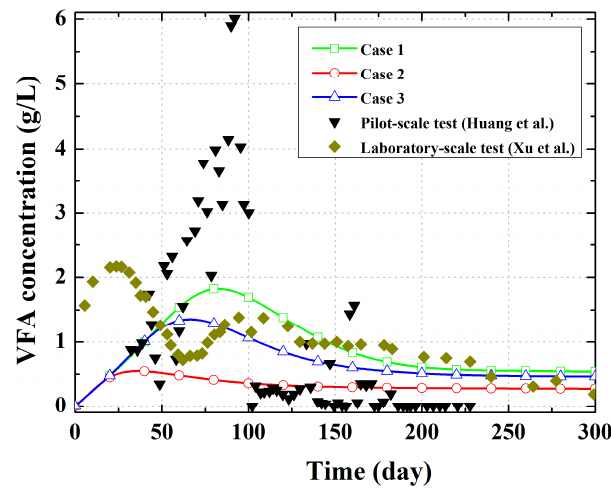
Figure 6. Validation of VFA concentration calculation results.